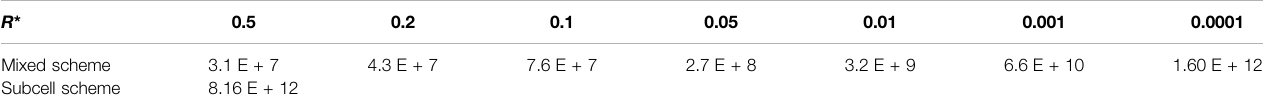
TABLE 5 | Condition numbers of Jacobian matrix obtained using two integration schemes with different critical partition ratios.